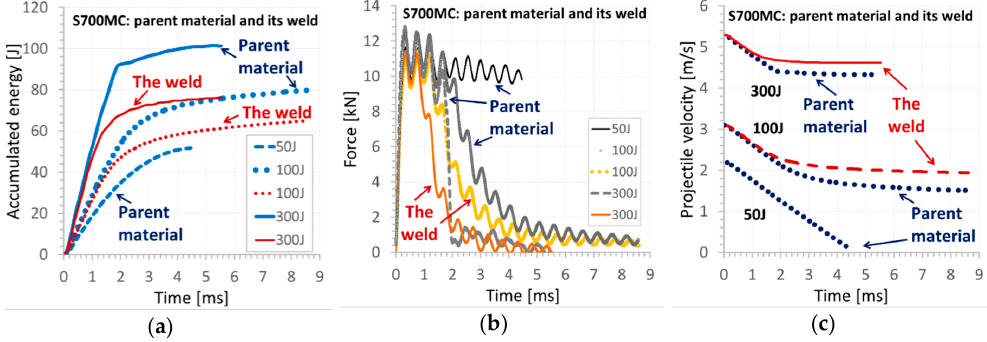
Figure 9. Variations of the following parameters: ( a ) accumulated energy; ( b ) force; ( c )